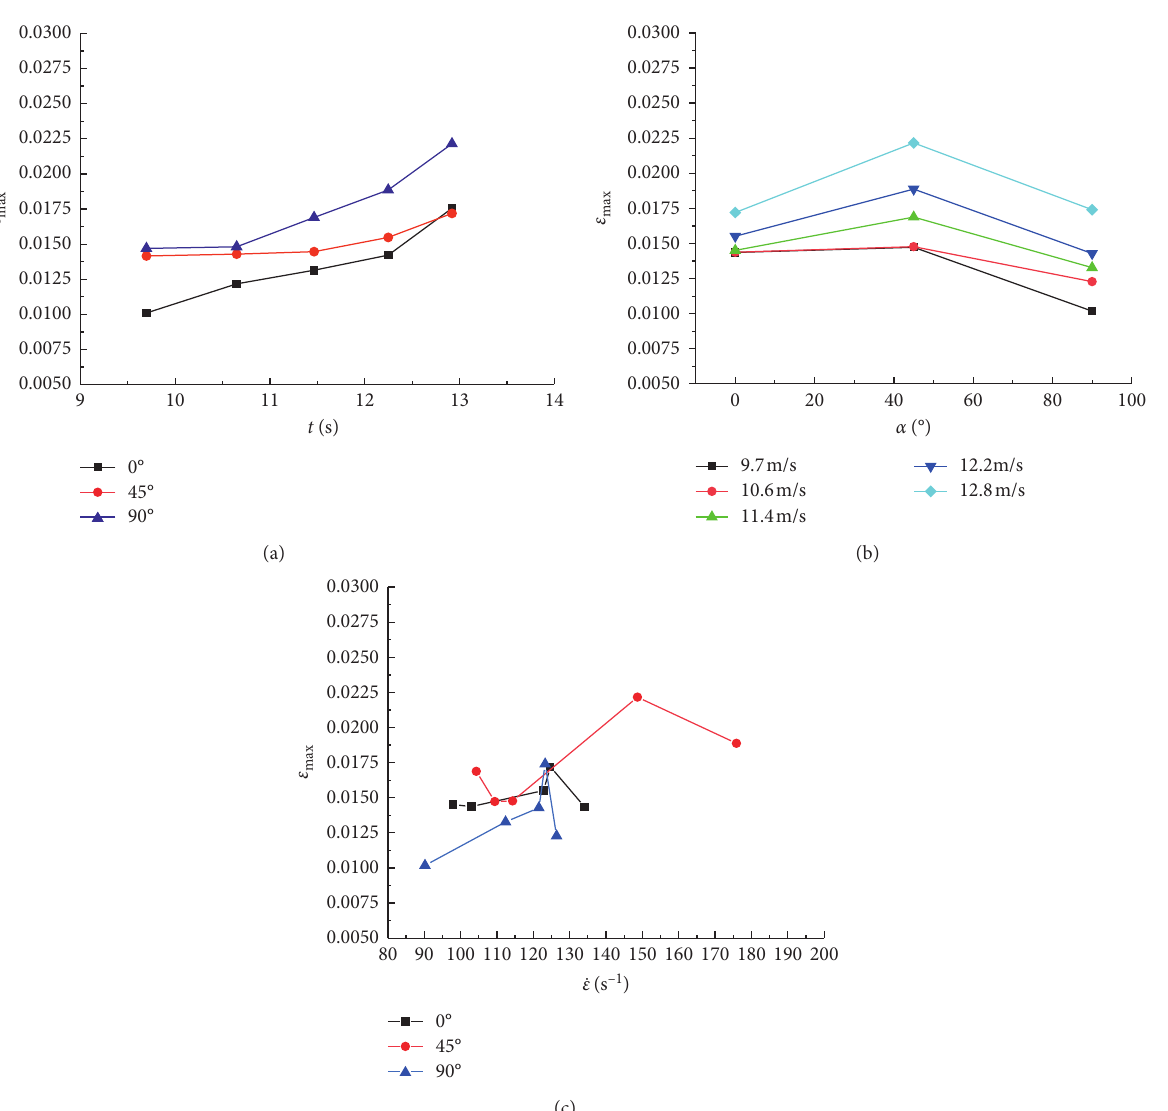
Figure 8: Relationship between peak strain and loading rate, prefabricated fracture angle, and strain